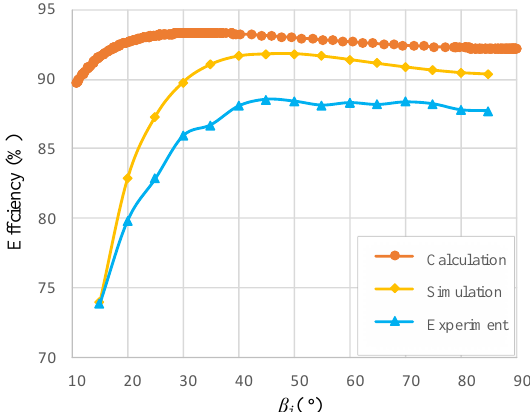
Figure 9. Efficiency trends obtained for mathematical model, simulation model, and experimental prototype.